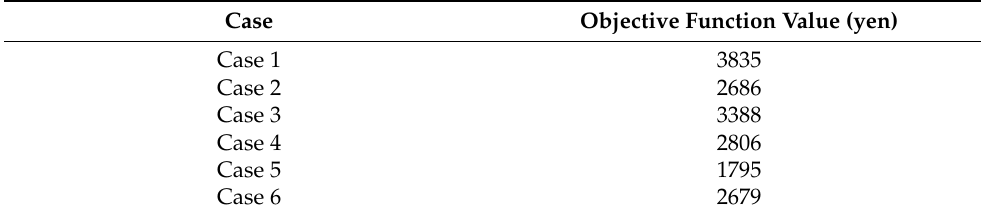
Table 3. Results of the objective function